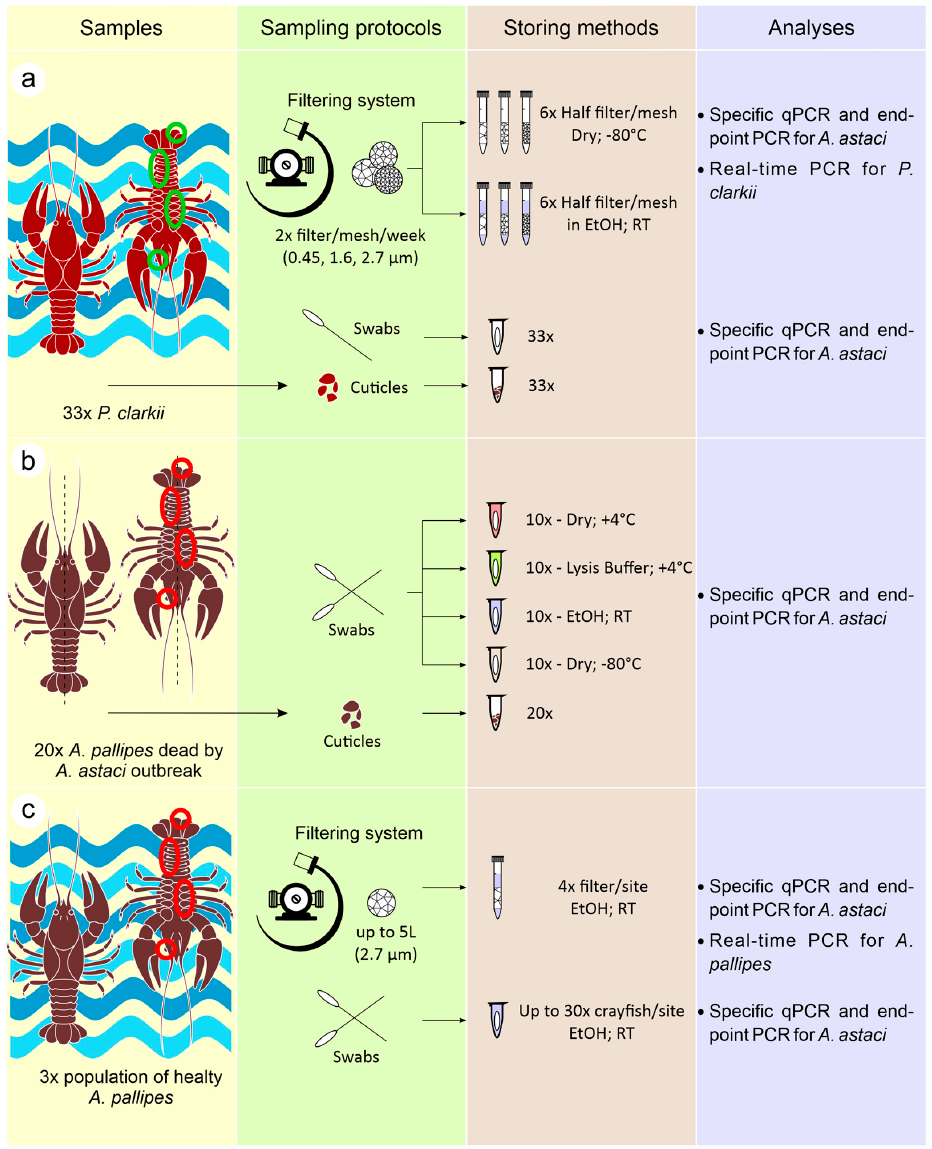
Figure 1. Experimental design. Graphical overview of the experimental design presented in the cur- rent work to summarise samples ( P. clarkii , A. pallipes , water), sampling protocols (eDNA, swabs, cuticles), number of specimens and storing method (solution, temperature) and performed analyses: